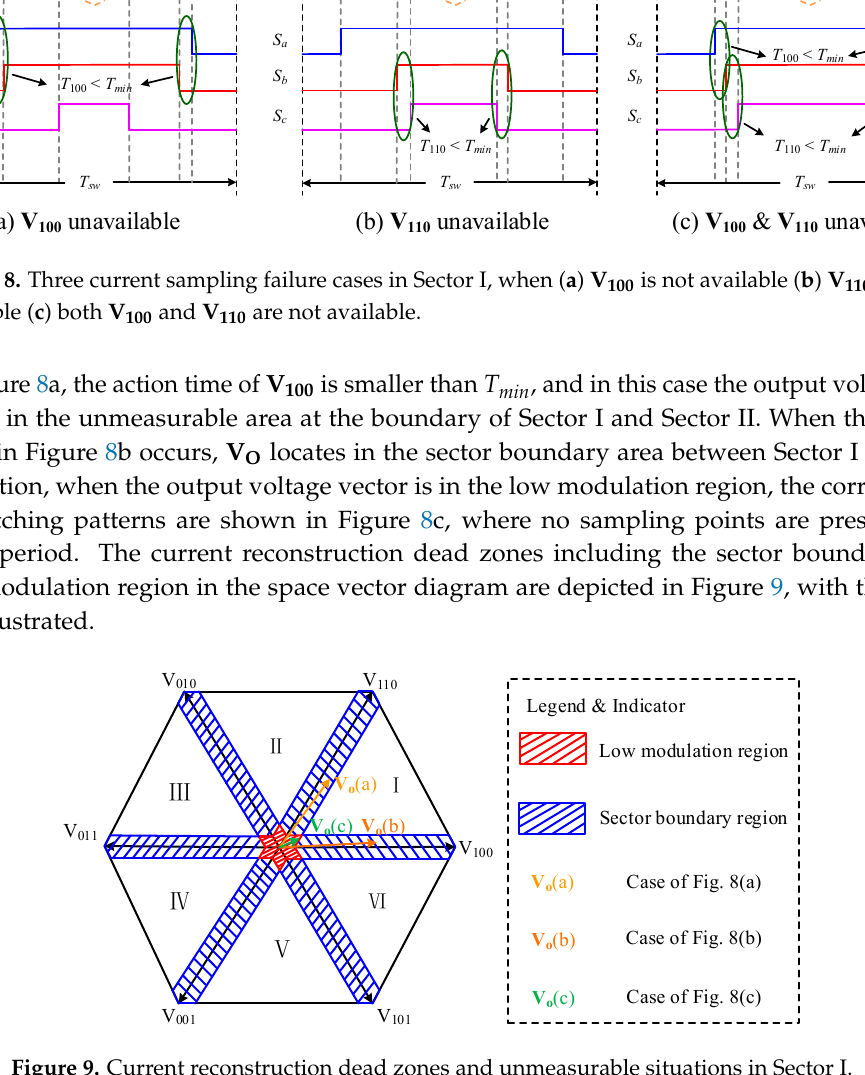
Figure 7. Ideal and actual current values in the turning on process.